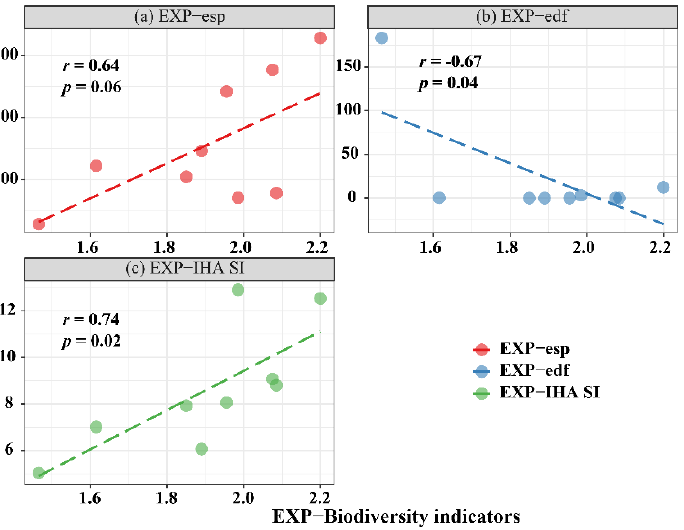
Figure 11. The correlation between measured and calculated biodiversity index, IHA-SI and ecological instream flow.